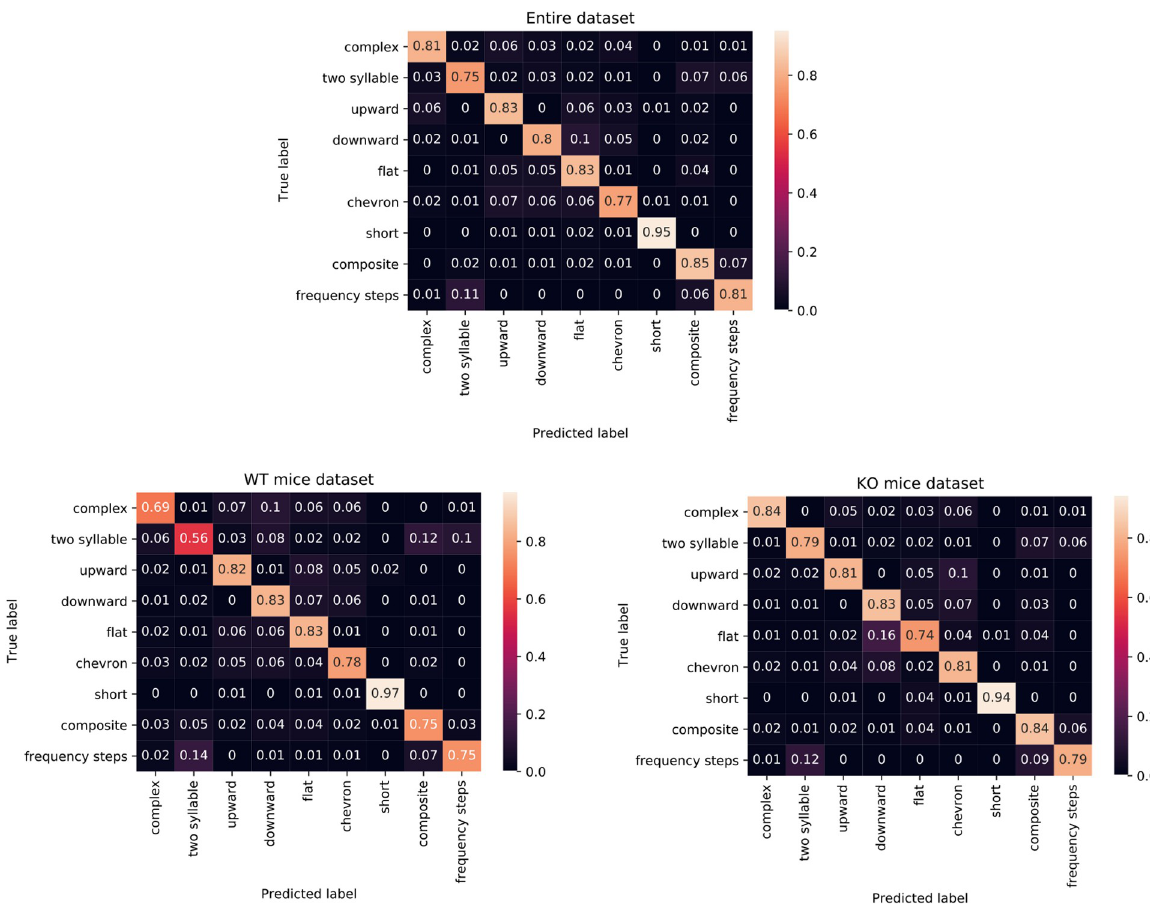
Fig 5. Confusion matrices related to the 9-categories classification results obtained testing the proposed CNN for the three datasets. On both axes there are the vocalization classes; in particular, the x axis refers to the predicted labels, while the y axis refers to the true ones. Notice that each row value is normalized with respect to the number of vocalizations of that row’s class. The values in the range (0;1) can be interpreted as percentage